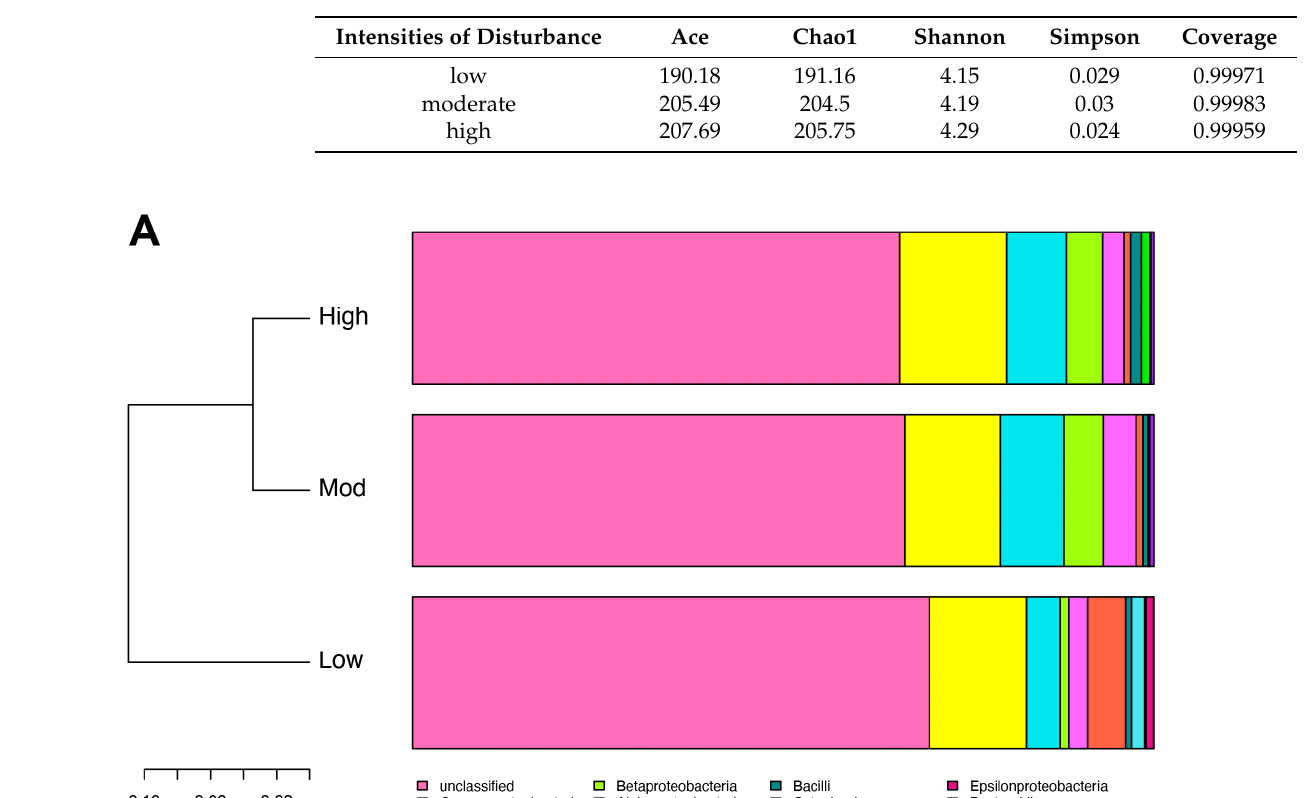
Table 3. Diversity index of various groups of denitrifying bacteria.